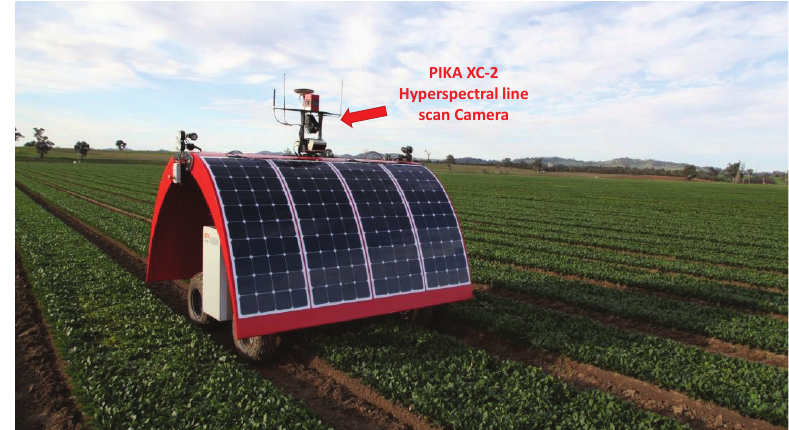
Figure 1. The Ladybird robot developed by Australian Centre for Field Robotics (ACFR) at The University of